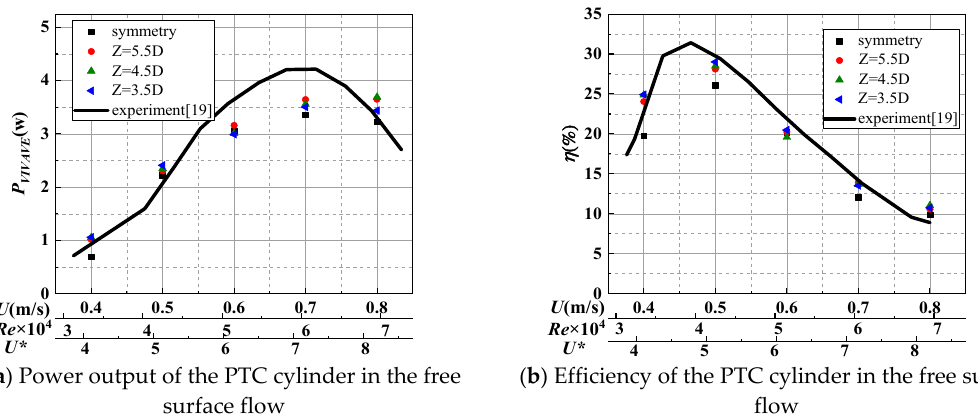
Figure 16. Comparison of the harness power and power conversion efficiency of VIVACE with the PTC cylinder in the free surface flow.